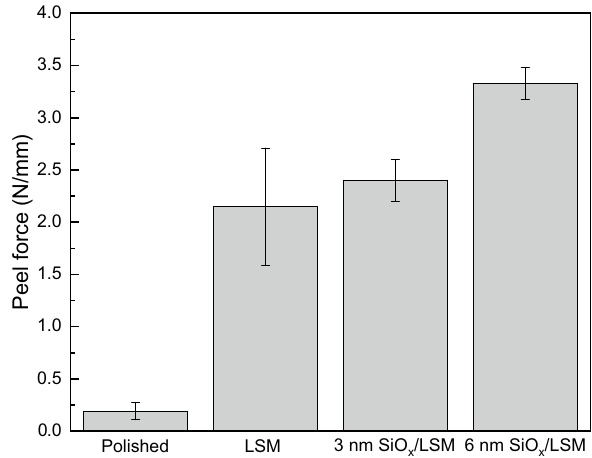
Fig. 8 90°-peel forces measured in a humid atmosphere on the polished and LSM Al-7075 alloy surfaces coated with epoxy-amine